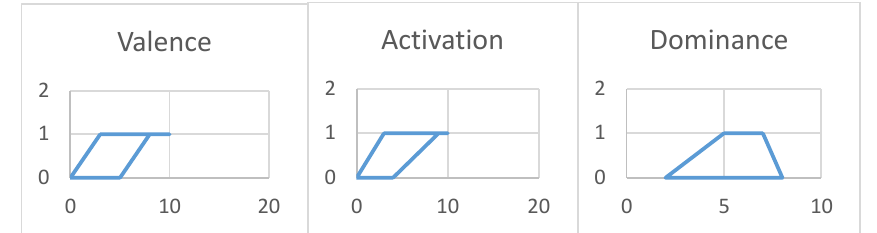
Fig. 13. The FOU of Onu (Joy) for dimensions valence, activation and dominance.